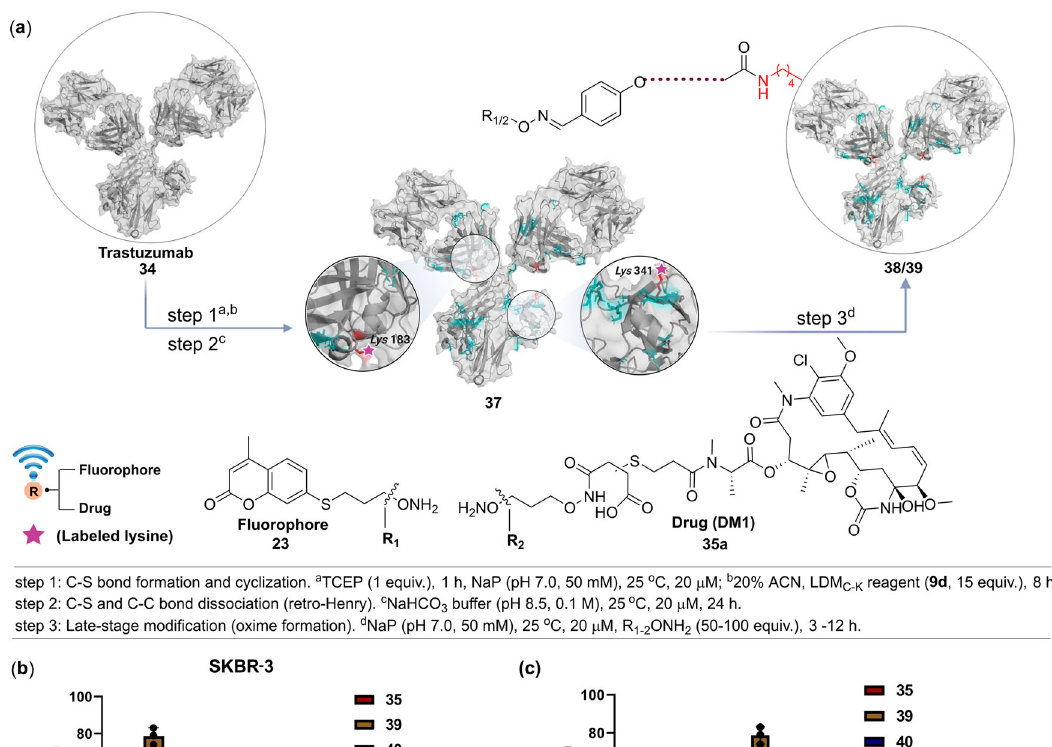
Fig. 8 | LDM C-K for homogeneous antibody- fl uorophore and drug conjugate (AFC and ADC). a LDM C-K reagent 9d renders homogeneous trastuzumab con- jugates with speci fi c modi fi cations of K183 and K341. Subsequently, AFC ( 38 ) and ADC ( 39 ) were prepared by late-stage installation of hydroxylamine derivative of fl uorophore (coumarin, 23 ) and drug (emtansine, DM1, 35a ). b Inhibition of cell proliferationby LDM C-K -ADC ( 39 ) ascompared to trastuzumab( 34 ), DM1 ( 35 ),and